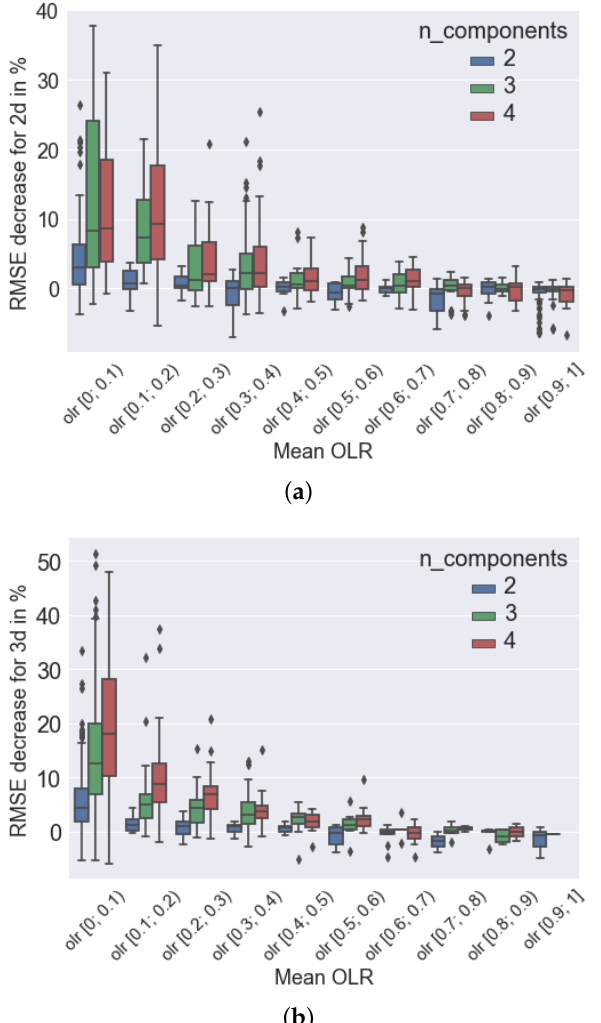
Figure 5. Reducing the average RMSE of all nodes as a percentage when using GMM for two- dimensional ( a ) and three-dimensional ( b ) cases. A negative value indicates that GMM is outper- formed by one Gaussian